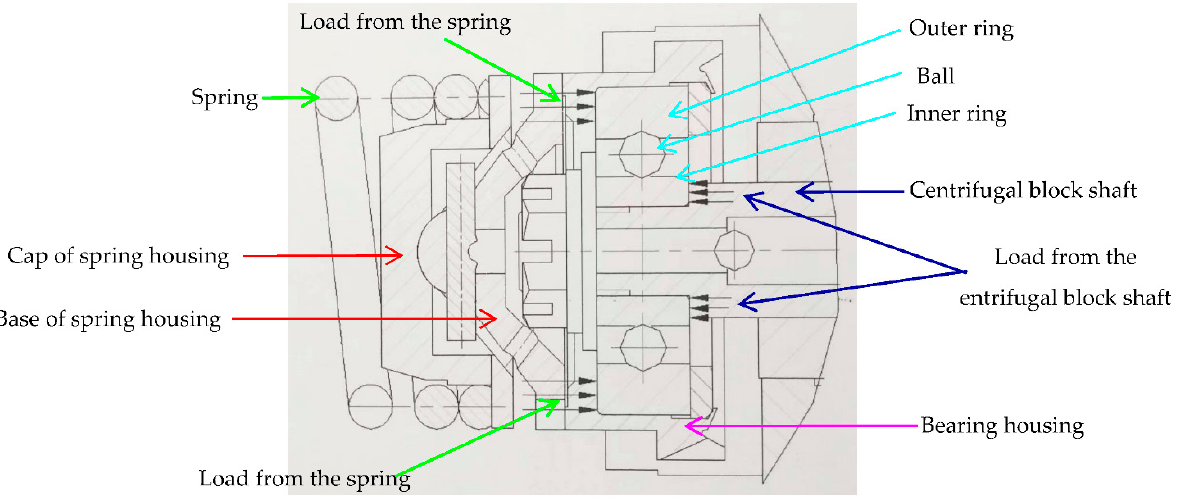
Figure 1. Assembly diagram of the deep-groove bearing.